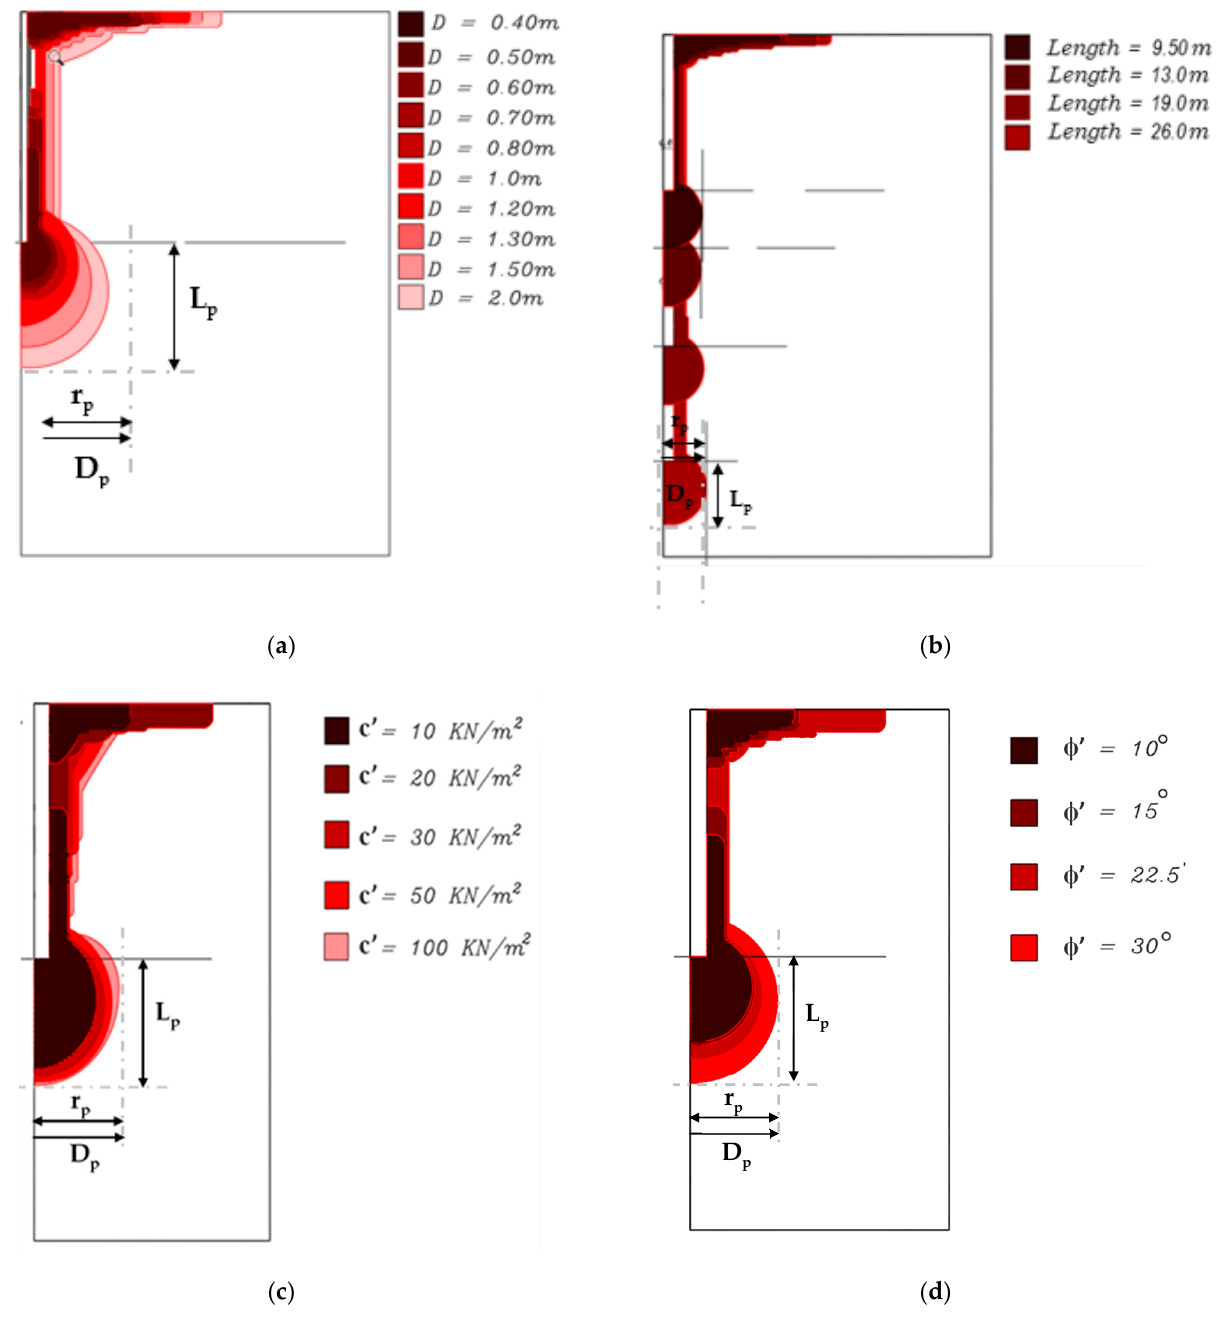
Figure 9. Influence in the formed plastic bulbs due to changes in different parameters. ( a ) Pile diameter (D). ( b ) Pile length (L). ( c ) Soil effective cohesion (c’). ( d ) Soil effective friction angle (Ø’).